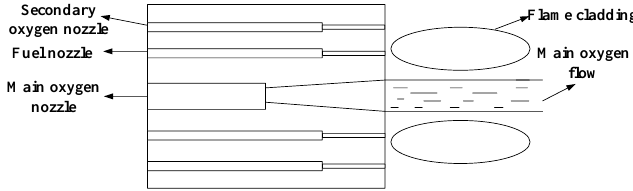
Figure 2. Schematic diagram of coherent jet oxygen lance blowing.